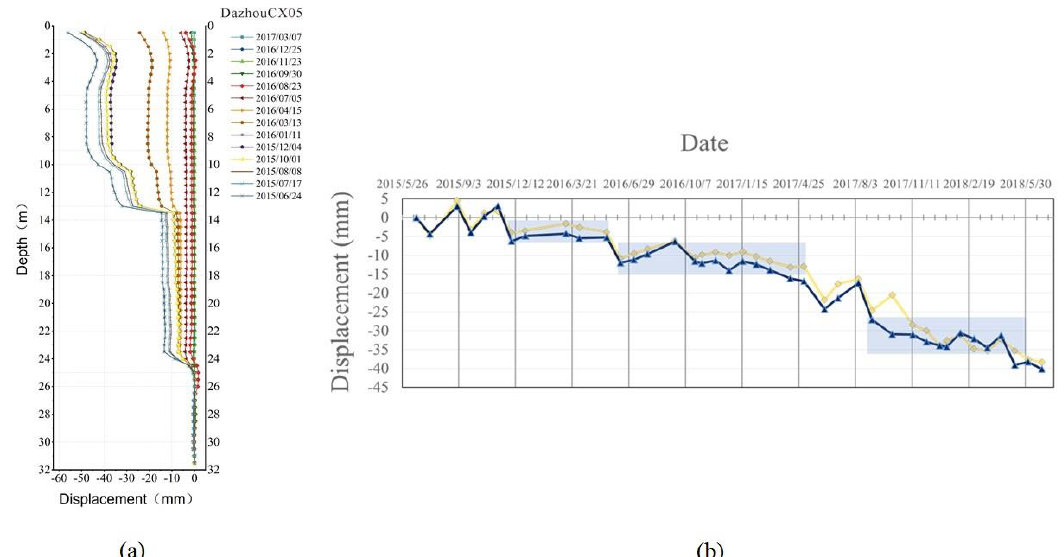
Figure 11. Monitoring data of the Dazhou landslide: ( a ) Borehole inclinometer data related to the time span June 2015–May 2018. ( b ) The PSInSAR deformation rate map of the Dazhou landslide, with the strong deformation area circled in red.